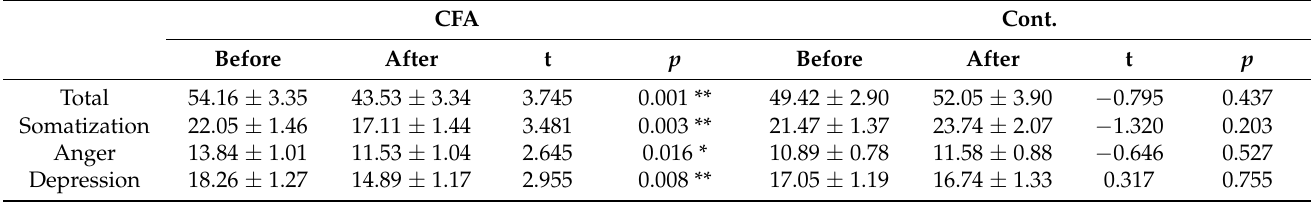
Table 3. The results of paired t -test analysis of modified form of the Stress Response Inventory (SRI-MF) scores. CFA Cont. Before After t p Before After t p Total 54.16 ± 3.35 Anger